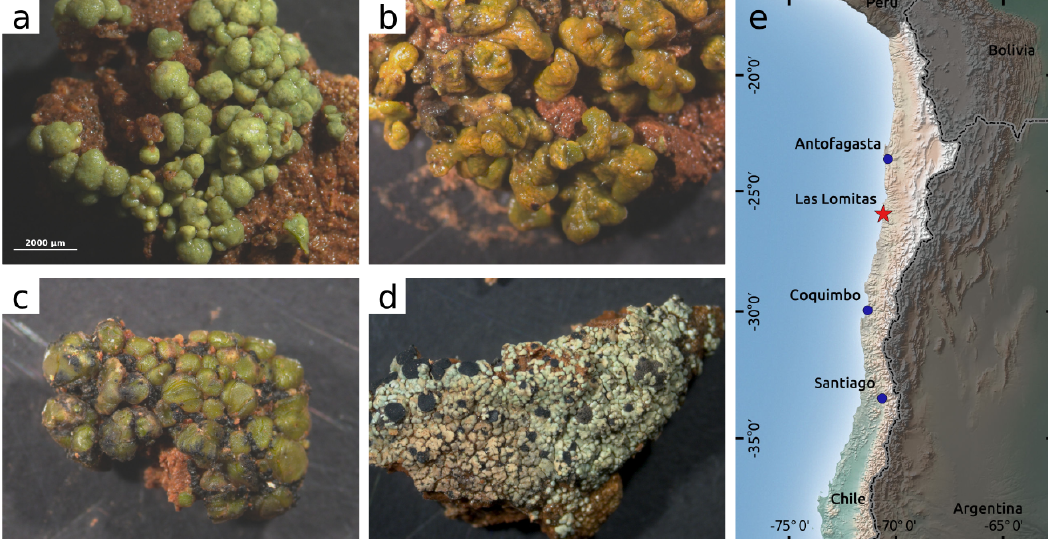
Figure 1. Images of wet biological soil crusts (BSCs): ( a ) Acarospora cf. gypsi-deserti , ( b ) Caloplaca santessoniana ad int. [34], ( c ) Placidium cf. velebiticum and ( d ) Rinodina sp. The map shows the sampling location (red star) near Las Lomitas in Chile ( e